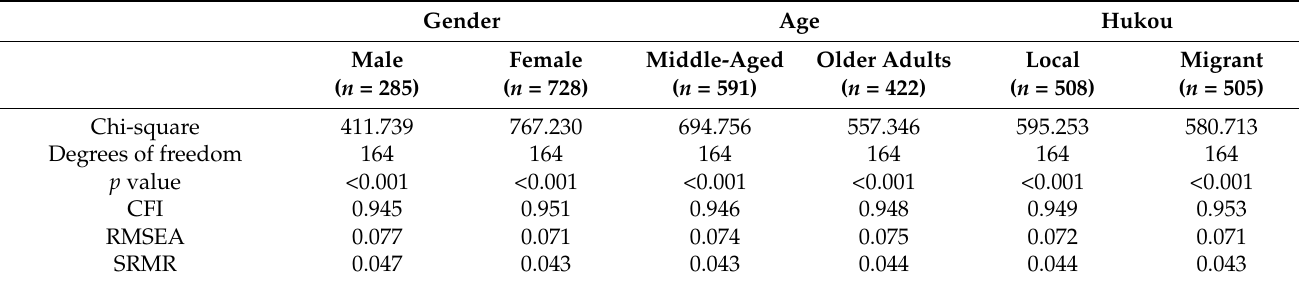
Table 2. Structural validation categorized by gender, age, and hukou.